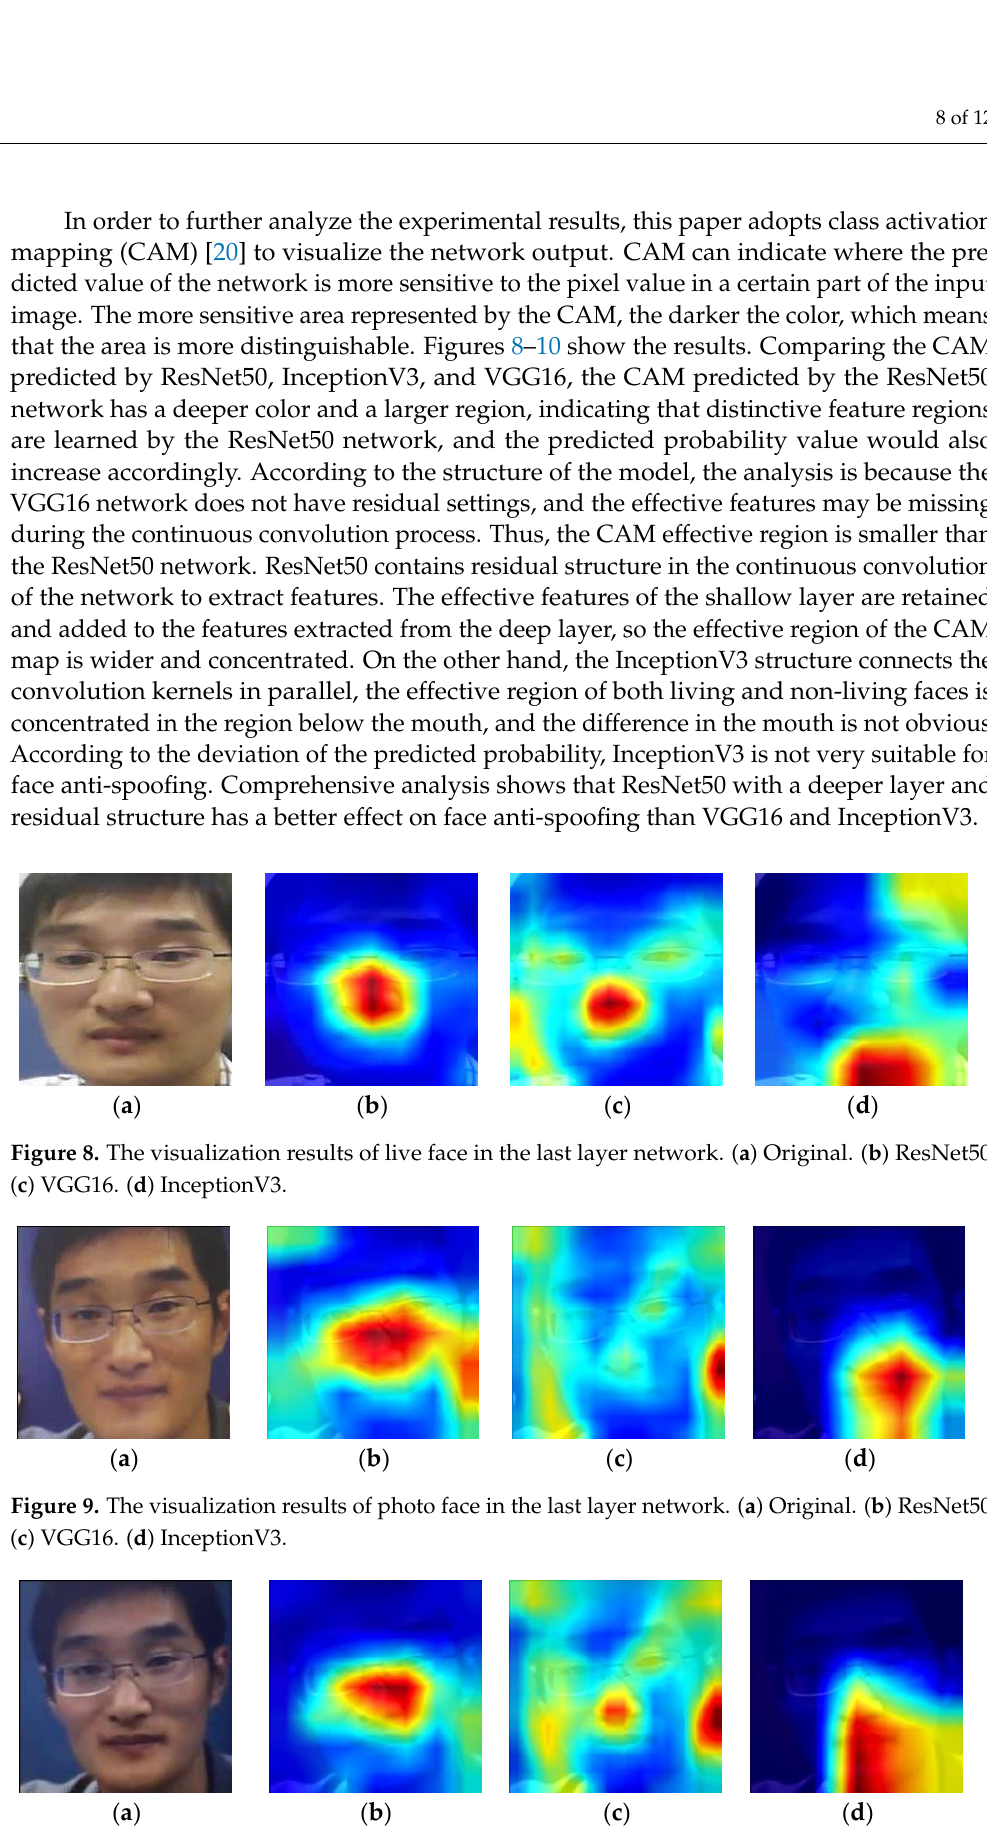
Figure 10. The visualization results of video face in the last layer network. ( a ) Original. ( b ) ResNet50. ( c ) VGG16. ( d ) InceptionV3.